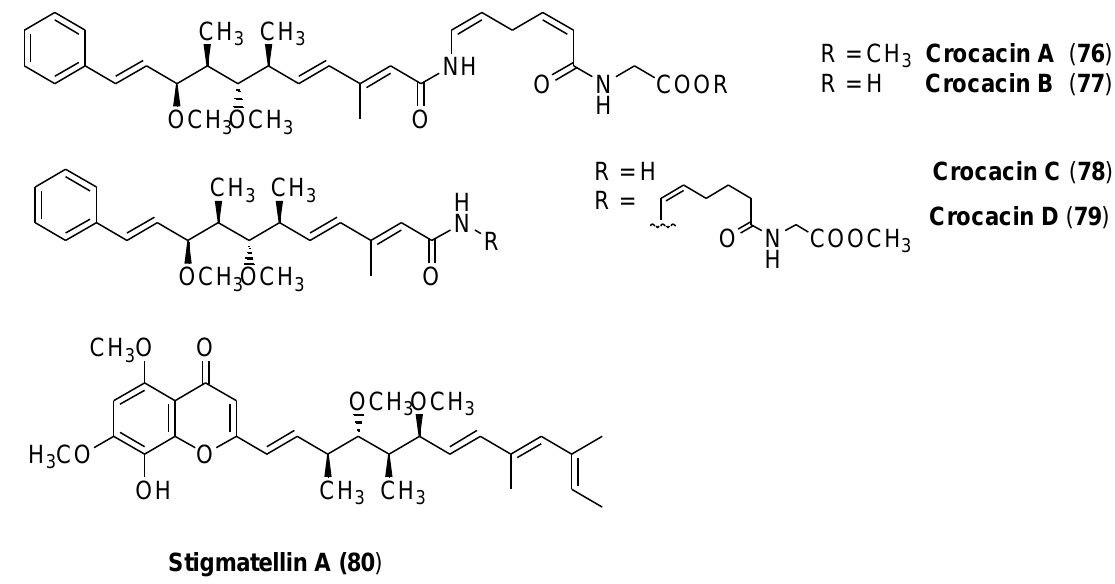
Figure 17. Structures of crocacins A–D ( 76 – 79 ) and stigmatellin A ( 80